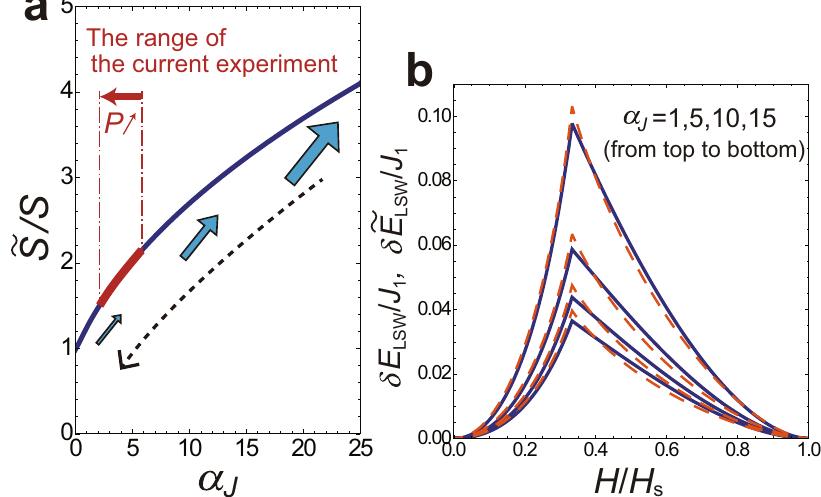
Fig. 9 Quantum correlation measure for coupled spin chains. a Increase rate of the effective spin ~ S in the squashed model from the original value S as a function of the ratio of the intrachain to interchain coupling, α J = J 0 / J 1 . b Energy differences between the umbrella and Y/UUD/V states, δ E LSW for the original model with α J = 1, 5, 10, 15 (blue-solid lines) and δ ~ E LSW for the squashed model with ~ S = S ¼ 1 : 24 ; 2 : 02 ; 2 : 69 ; 3 : 23 (orange-dashed lines), within the leading 1/ S (linear spin-wave) corrections.